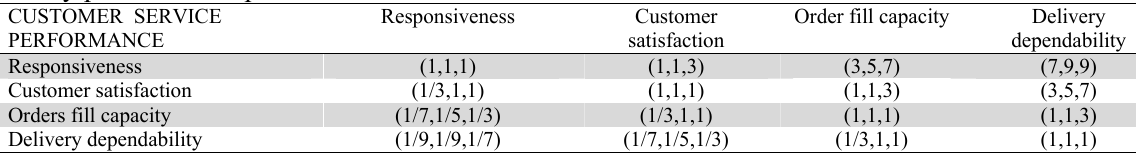
Fuzzy pair-wise comparison of Customer Service Performance Enablers CUSTOMER SERVICE PERFORMANCE